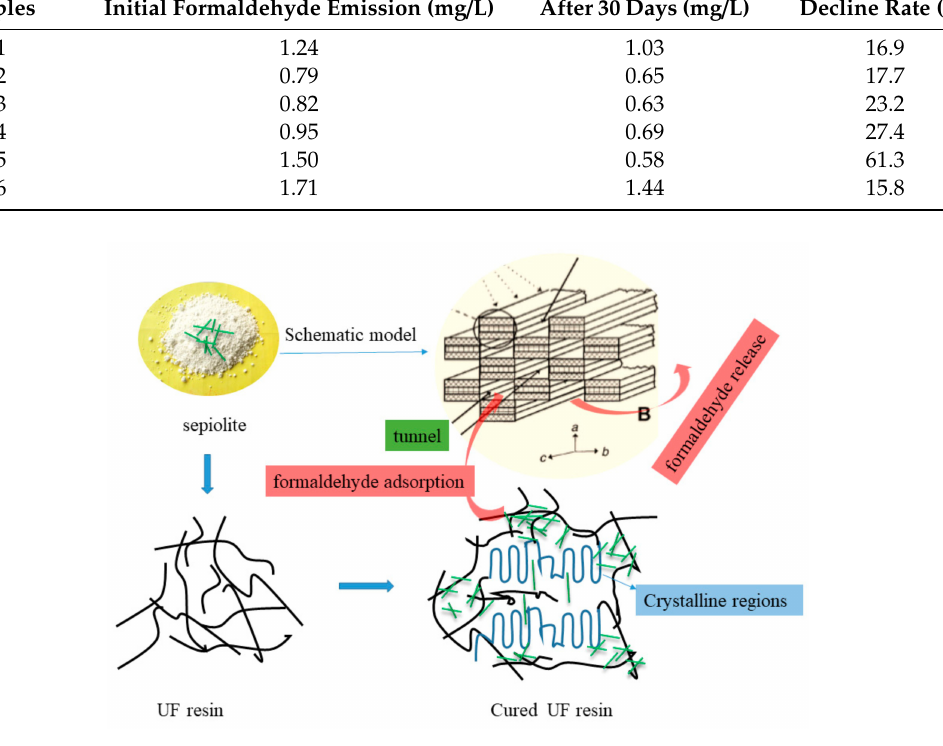
Figure 3. Schematic model of tunnel-structured SEP and the absorption and release method of